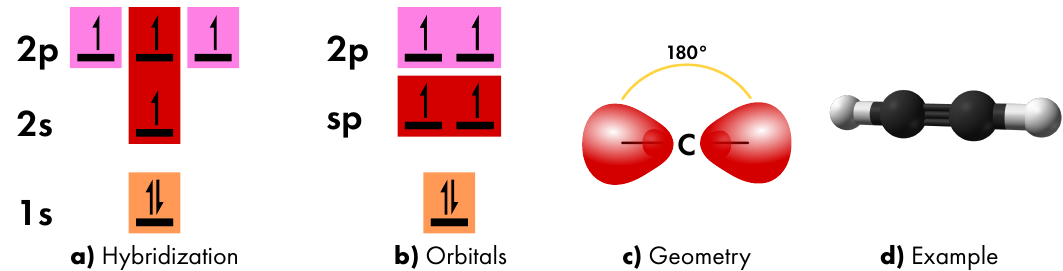
Figure 3. ( a ) sp hybridization scheme and ( b ) resulting electronic configuration with hybrid orbitals,